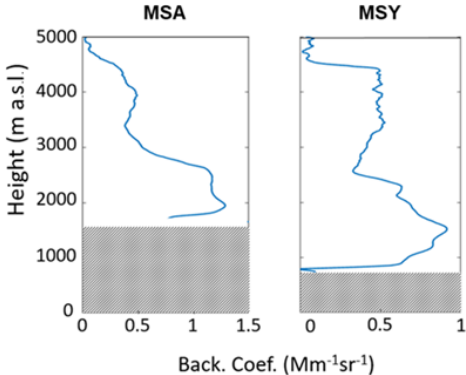
Figure 26. Profiles of the backscatter coefficient derived at 1064nm in MSA and MSY for the 28 July 2017 from 12:50 to 13:20UTC. The grey shadings indicate the height of the ceilome-